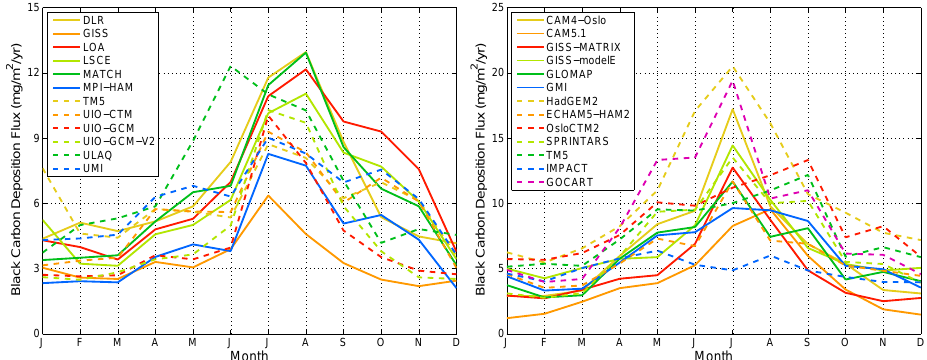
Fig. 9. Seasonal cycle of black carbon deposition fluxes averaged over the Arctic (60 ◦ N to 90 ◦ N) for Phase I (left) and Phase II (right) models. (Note the scale on ordinate is different for the two plots.)